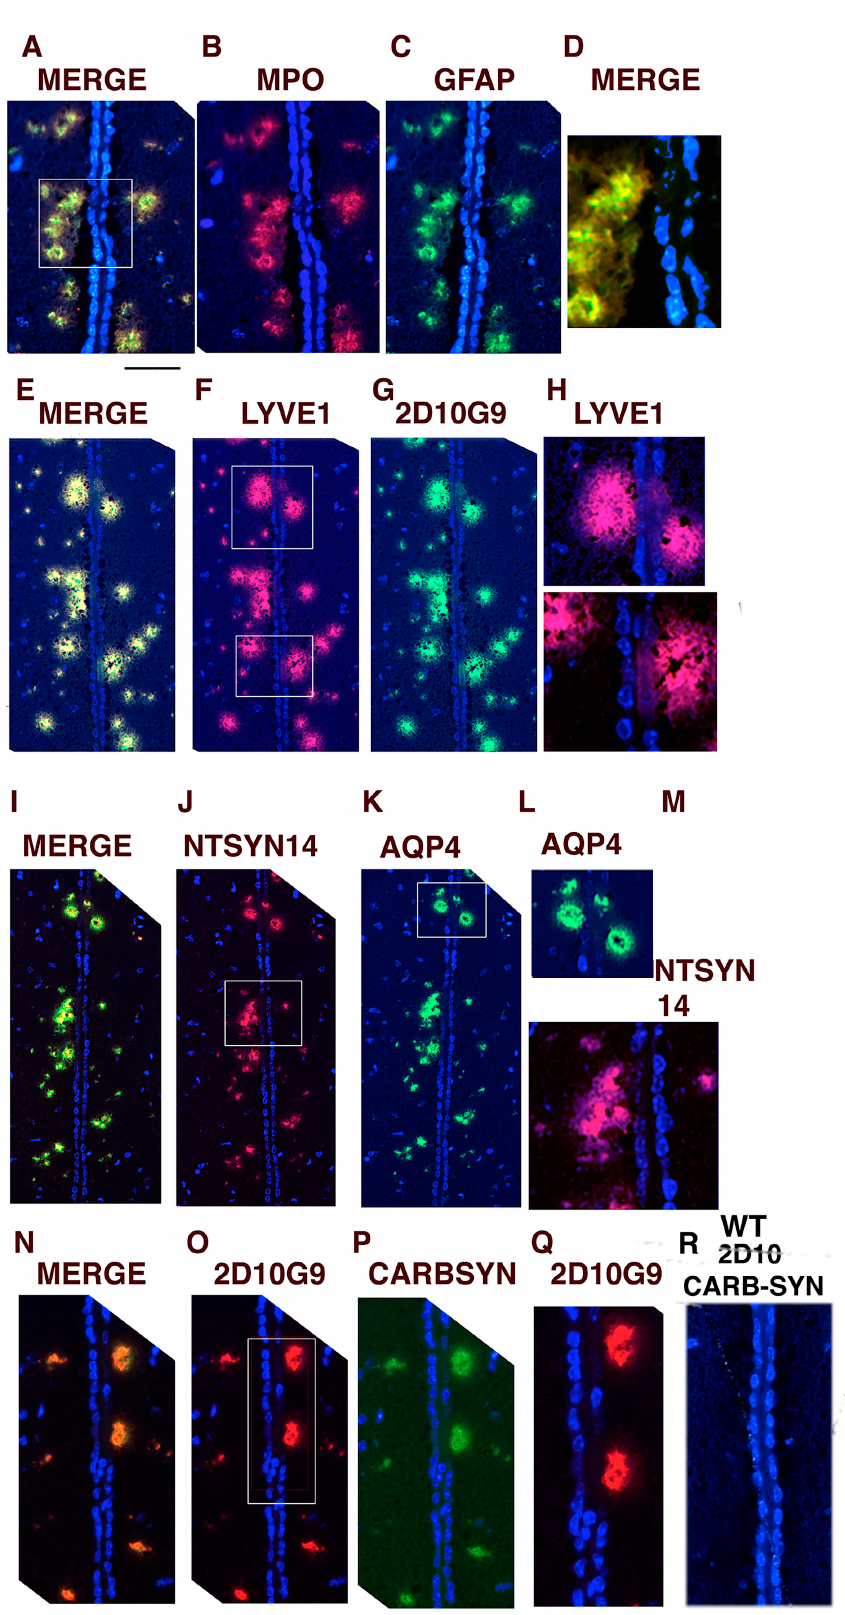
Figure 5. Colocalization for LYVE1, AQP4, MPO, GFAP, ntSyn14, HOCl oxidized epitopes, and carbsyn in periventricular vessels can be toxic to ependymal cells in hMPO-A53T mice. ( A – D ) Panels ( A – D ) show colocalization of MPO ( B ) and GFAP ( C ), marker for activated astrocytes, with